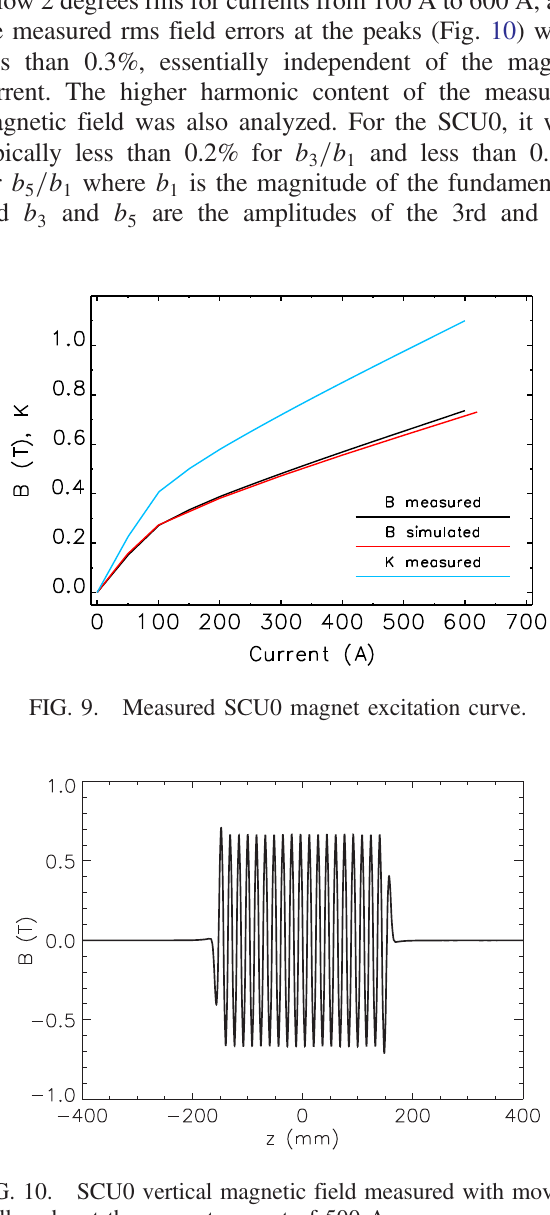
FIG. 10. SCU0 vertical magnetic field measured with moving Hall probe at the magnet current of 500